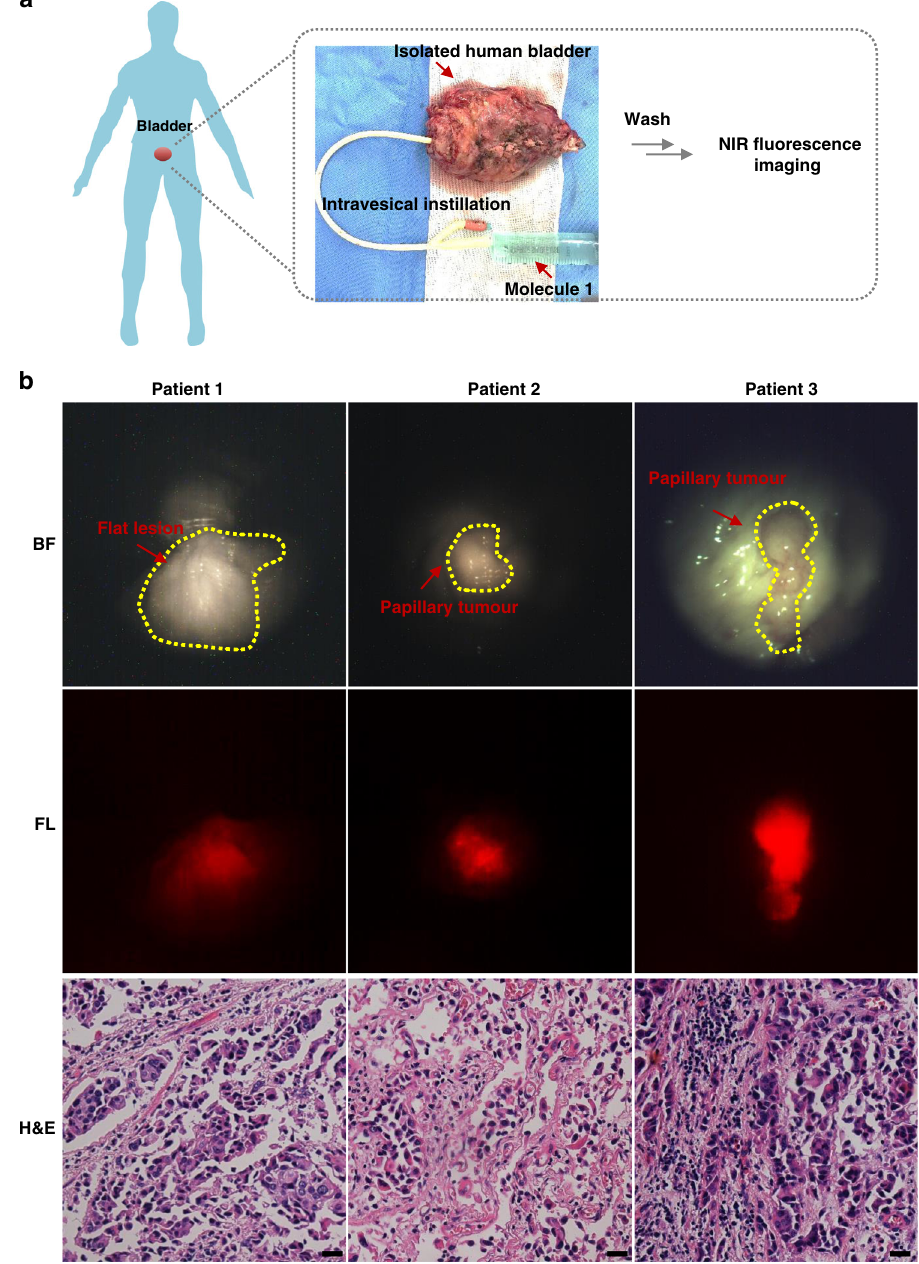
Fig. 7 Ex vivo imaging of human intact bladder of TCASS. a Schematic illustrated the procedure of intravesical instillating the molecule 1 using ex vivo human intact bladder. b NIR fl uorescence imaging of human bladder tumour tissues of three patients and their corresponding H&E stained. Scale bar: 20 μ